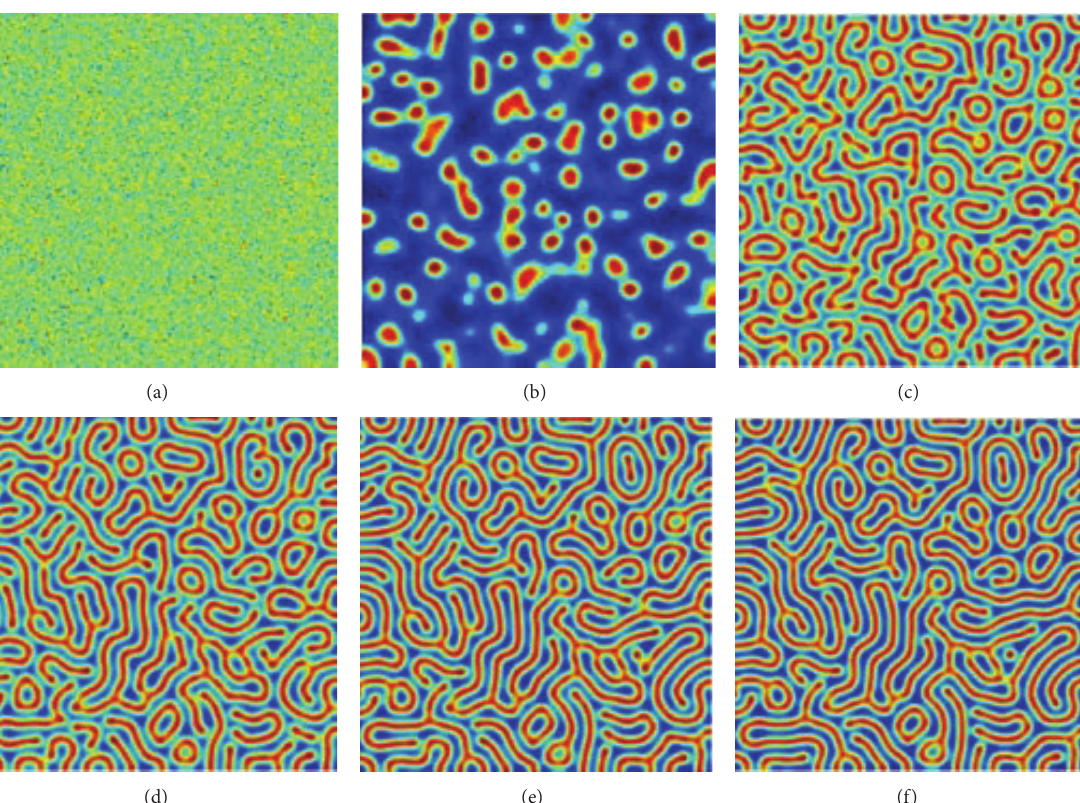
Figure 4: Spatial pattern of prey population at different time. Parameters set: 𝛾 = 1.5 , 𝜀 = 0.15 , and 𝛿 = 0.96 . (a) 𝑡 = 0 ; (b) 𝑡 = 50 ; (c) 𝑡 = 100 ; (d) 𝑡 = 200 ; (e) 𝑡 = 500 ; and (f) 𝑡 = 1000